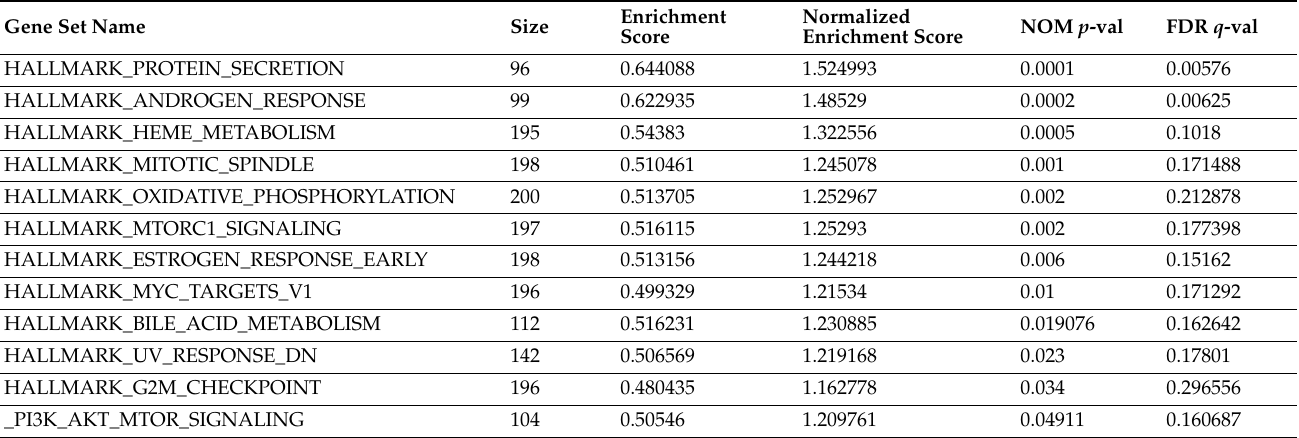
Table 1. Significantly enriched gene sets in the traditional treatment group, compared to alternative scheduling